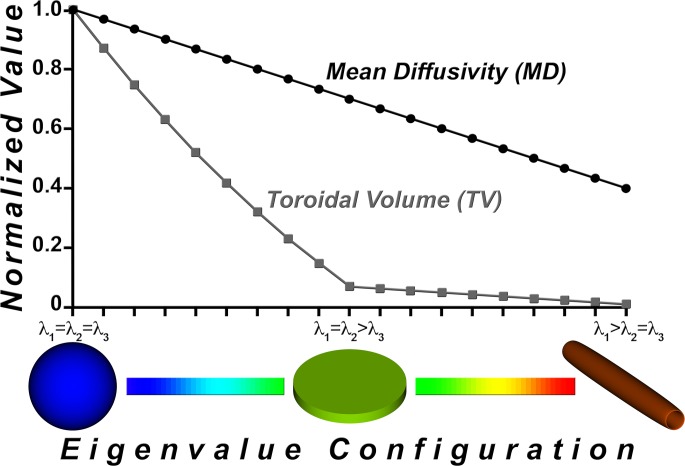
Comparison of the toroidal volume (TV) and mean diffusivity (MD) indices.Diffusivity indices TV and MD, each normalized to [0, 1], and displayed as a function of eigenvalue configuration. MD is a linear function whereas TV exhibits a nonlinear response to the increase in anisotropy. The inflection point in the TV curve profile from isotropy to anisotropy enhances tissue discrimination as compared to MD.